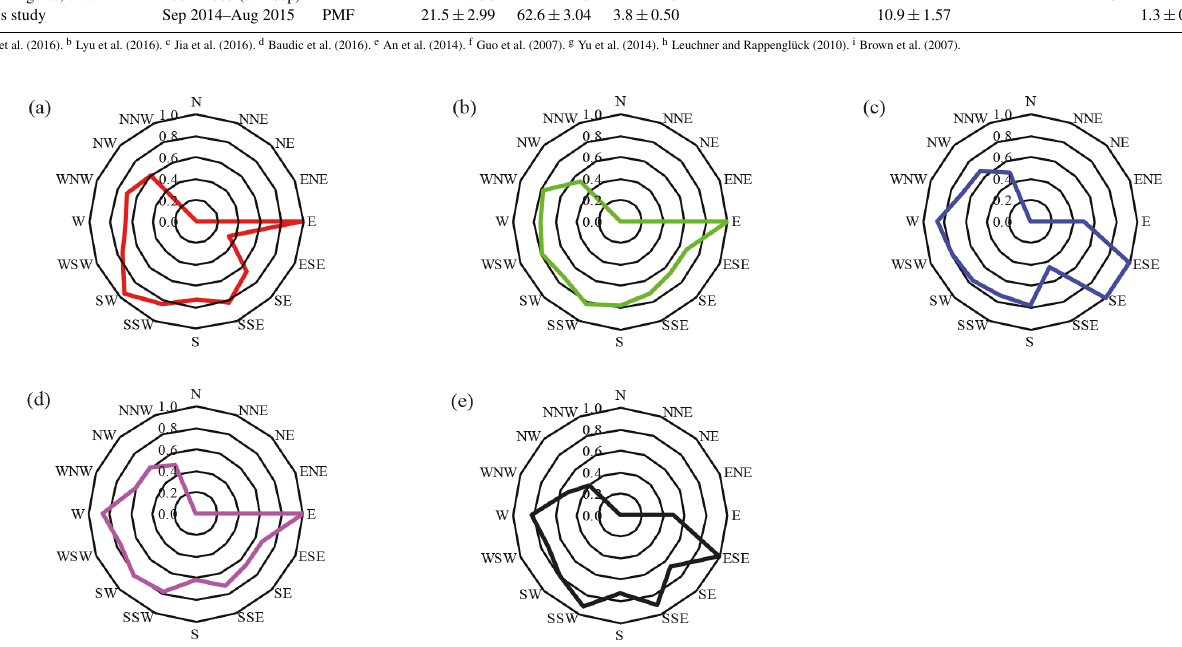
Figure 14. Annual conditional probability function (CPF) plots of five identified VOC sources including oil refineries (a) , NG (b) , combus- tion (c) , asphalt (d) and fuel evaporation (e)